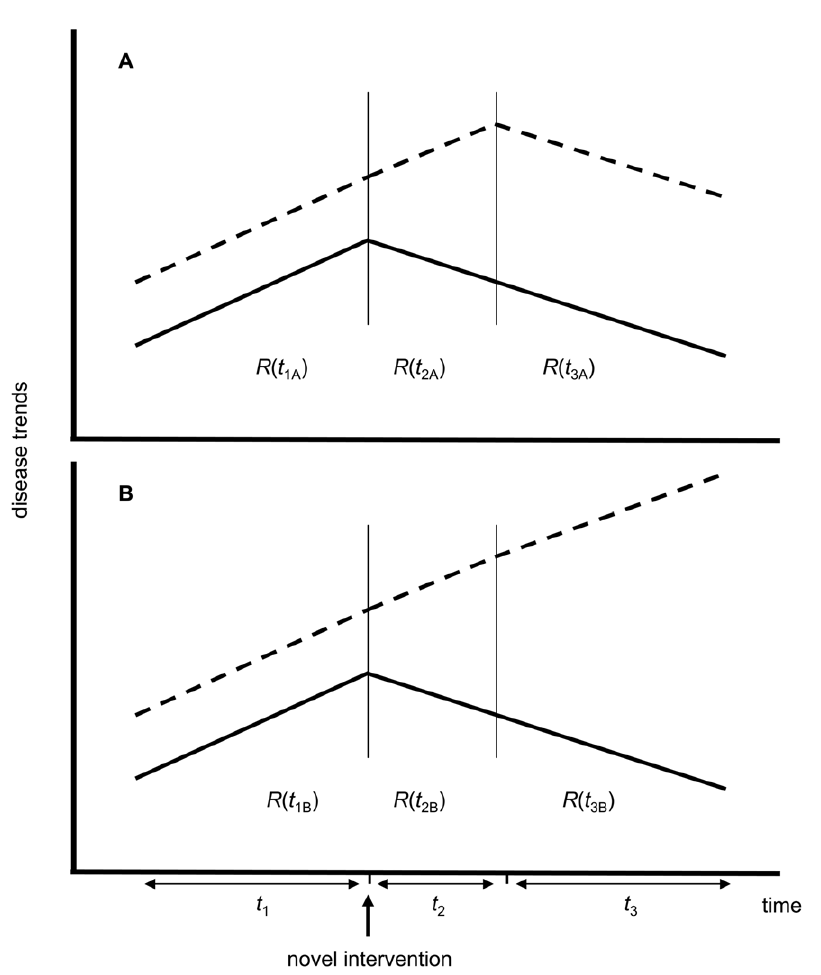
Figure 3. Schematic illustrating the population-level response of the HIV and TB epidemics to a novel HIV control measure. The relative growth rates of percent HIV prevalence (solid line) and TB incidence (dashed line) epidemics before and after the novel intervention (which for example could be the delivery of a new antiretroviral) are captured by R TB = HIV ( t i , n , r ) in three different time intervals i =1, 2 and 3. These intervals start before the novel intervention (with t 1 representing the first year for which we have data), when the novel intervention is first implemented (at year t 2 ), and for the period starting at the point when TB incidence first decreases in scenario A (at year t 3 ). Years t 2 and t 3 are represented by vertical lines. Because this diagram is a simple schematic we will not define exact values for the parameters t i , n and r . While in both scenarios HIV prevalence decreases, in (A) TB incidence decreases after a certain time lag such that (omitting subscripts and common argument values) R ( t 1 A ) ~ R ( t 3 A ) ~ 0 v R ( t 2 A ) , while in (B) TB incidence continues to increase and R ( t 1 B ) v R ( t 2 B ) v R ( t 3 B ) , indicating that TB control is not reaping the benefits anticipated from the new HIV control measure.